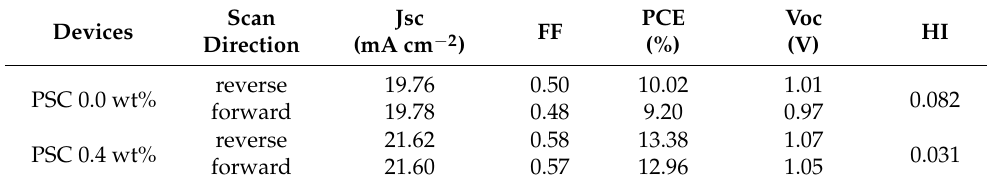
Table 4. Photovoltaic data of the PSC 0.0 wt% and PSC 0.4 wt% measured in forward and reversed scans.